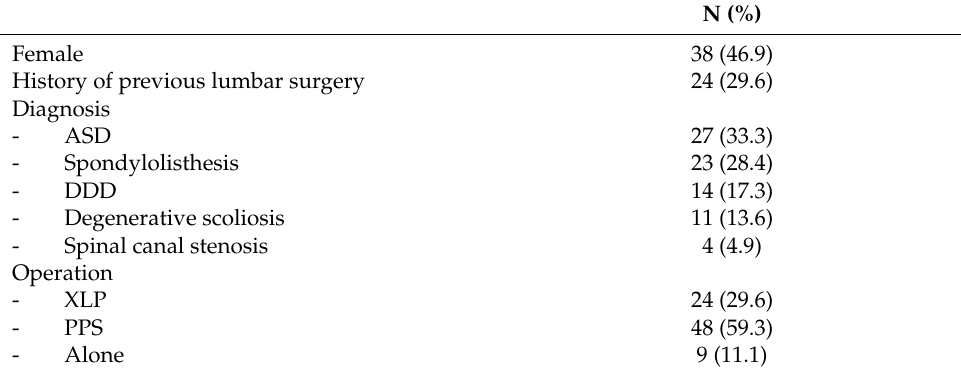
Table 1. Patient demographic information ( n =